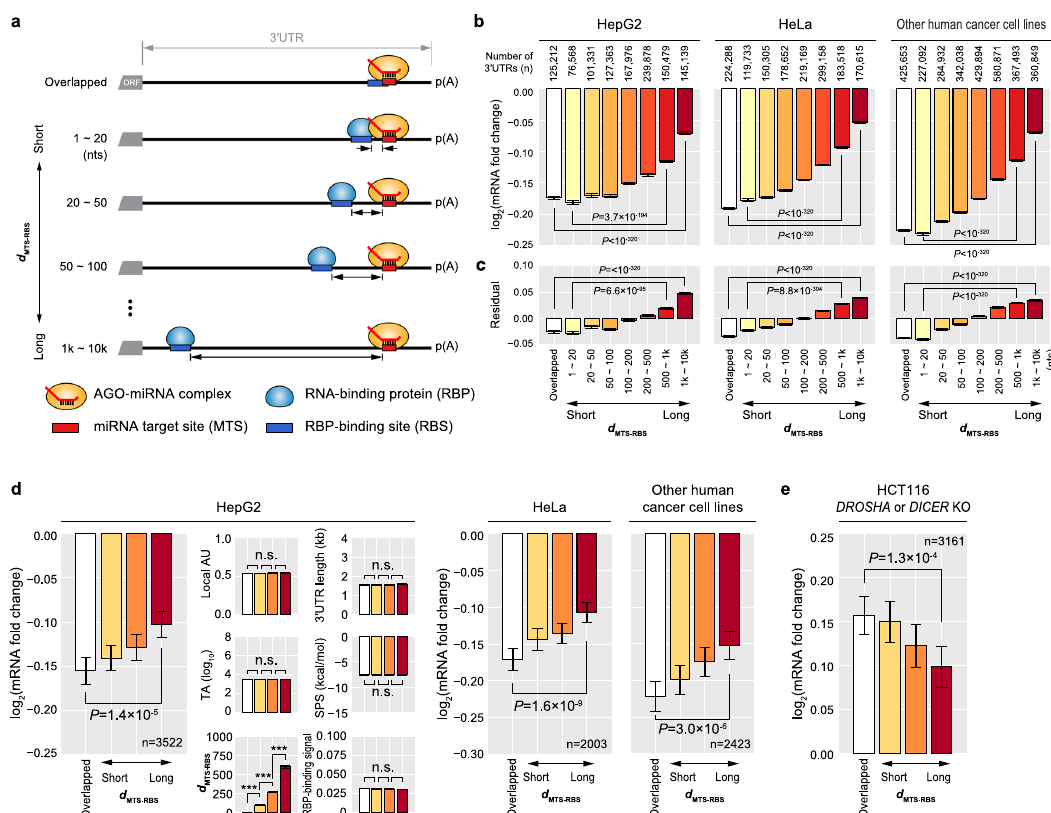
Fig. 1 RBP binding close to a miRNA target site is associated with enhanced miRNA targeting. a Overview of the analysis to investigate the effect of RBP binding on the miRNA targeting (MT) ef fi cacy. Genes were grouped together based on the distance between a miRNA target site (MTS) and the nearest RBP-binding site (RBS) on the 3 ′ UTR, denoted as d MTS-RBS . The genes with an MTS that overlaps with an RBS were categorized as ‘ overlapped ’ . The association between MT ef fi cacy and d MTS-RBS was analyzed by measuring the mRNA fold change. b Association analysis between d MTS-RBS and MT ef fi cacy. The mean mRNA fold changes of 3 ′ UTRs with a single 7, 8mer MTS obtained from mRNA-seq (HepG2) or microarray datasets (HeLa and other human cancer cell lines) that monitored the whole-transcriptome response to overexpressed miRNAs/siRNAs are shown. The 3 ′ UTRs were grouped with respect to d ′ UTR groups (two-sided Wilcoxon ’ s rank-sum test). The number of 3 ′ MTS-RBS , as depicted in ( a ). The mRNA fold changes were compared between the 3 UTRs used for measuring d MTS-RBS is shown on top. mRNA fold changes are displayed in the log2 scale and the error bars represent 95% con fi dence intervals. c Residuals of the mRNA fold change for each group from ( b ) after correcting for four known confounding features of MT (local AU content, target abundance (TA), seed-pairing stability (SPS), and 3 ′ UTR length). The regression residuals represent the remaining information after reducing the contribution from the confounding features. Otherwise as in ( b ). d Association analysis between d MTS-RBS and MT ef fi cacy after a more rigorous correction for the confounding features. A subset of 3 ′ UTRs analyzed in ( b ) were selected and split into four subgroups with respect to the d MTS-RBS . Each subgroup was carefully chosen to have statistically indistinguishable confounding features between each other (see Supplementary Fig. 1f for full versions). The mean values of confounding features, d MTS-RBS , and log 2 (mRNA fold change) are displayed ( *** P < 0.001). Otherwise as in ( b ). e Association analysis between d fi cacy after deleting DROSHA or DICER . Five miRNAs whose targets show the strongest derepression in response to miRNA removal were MTS-RBS and MT ef chosen and the association between d MTS-RBS and MT ef fi cacy was evaluated. See Supplementary Fig. 1h for full versions. Otherwise as in ( d